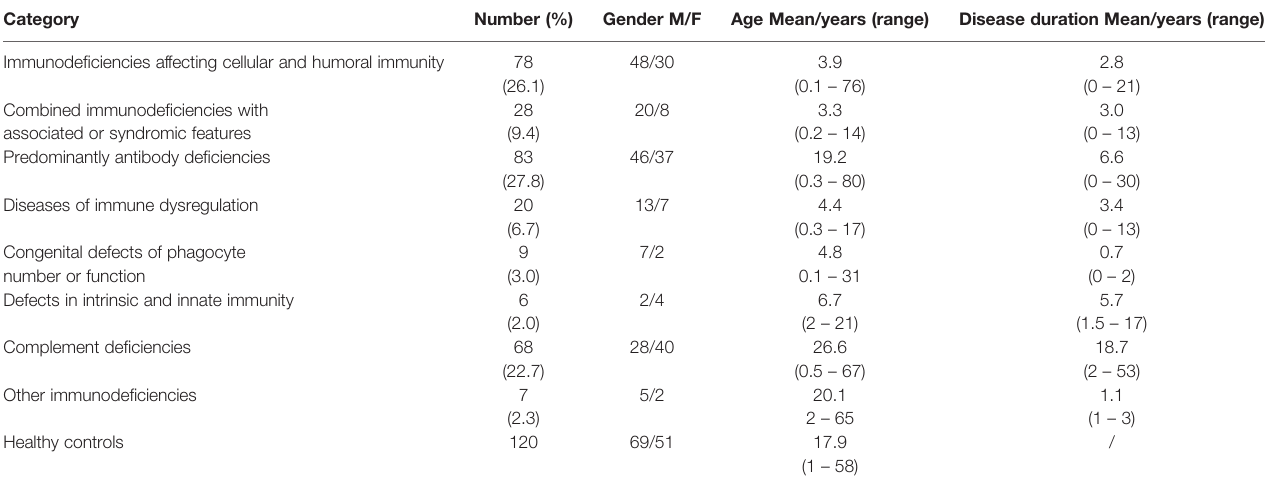
TABLE 2 | Demographic data of PID patients and healthy